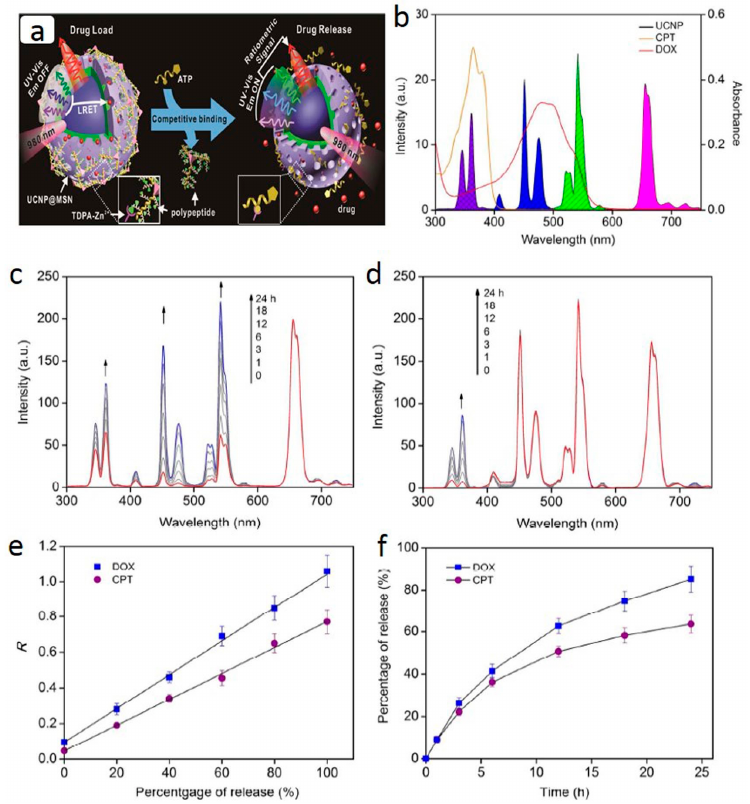
Figure 5. ( a ) schematic drawing of real-time monitoring of ATP-responsive drug release based on polypeptide wrapped zincdipicolylamine-Zn 2+ -upconversion nanoparticles@mesoporous nanoparticles (TDPA-Zn 2+ -UCP@MSN); ( b ) spectrum overlaps between the absorption of anticancer drugs doxorubicin (DOX) and camptothecin (CPT) and the emission of the core-shell UCP@MSN; ( c , d ) time-dependent emission spectrum of the polypeptide wrapped TDPA-Zn 2+ -UCP@MSN loaded with DOX and CPT in the presence of 5 mM ATP, respectively; ( e ) linear relationships between the percentage of drug release and the ratiometric signal (R) of the UCP. For DOX, R is the ratio of I 472nm to I 656nm and R for CPT is the ratio of I 365nm to I 656nm ; and ( f ) time-dependent release for DOX and CPT monitored based on the ratiometric emission of UCP. Reproduced with permission from